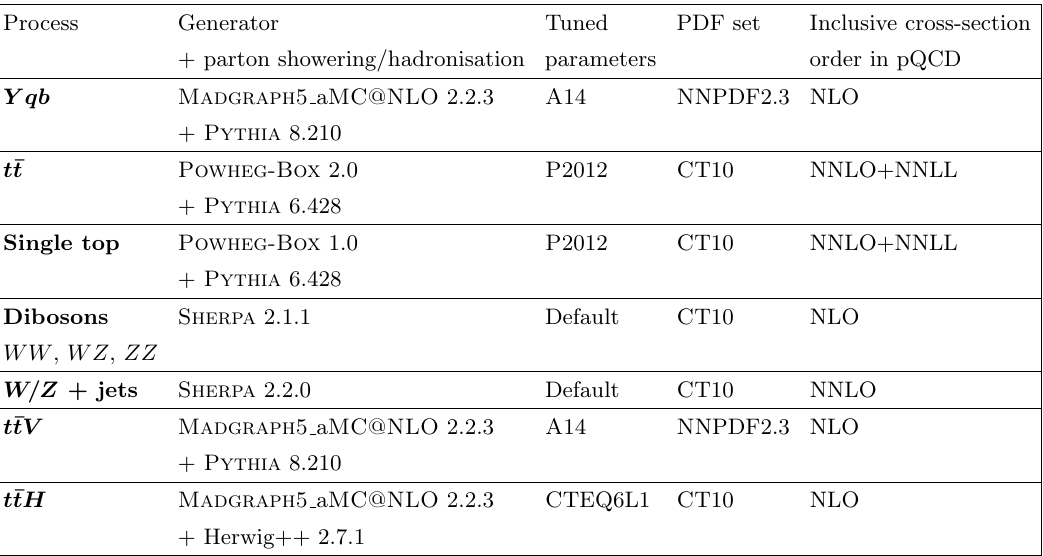
Table 1. Generators used to model the signals and di(cid:11)erent background processes. The parameter tune for the underlying event, PDF set, and the highest-order perturbative QCD (pQCD) accuracy used for the normalisation of each sample is given. All processes, except for Y qb signals, were generated at NLO in QCD. The LO cross-sections calculated for the Y qb signal processes in the simulation were normalised to the NLO theoretical cross-section taken from ref.